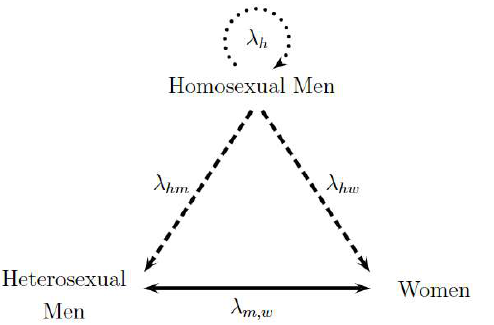
Figure 1. Triangle Transmission in Sexual Preferences: Homosexual Men and Heterosexual Men and Women. Adapted from